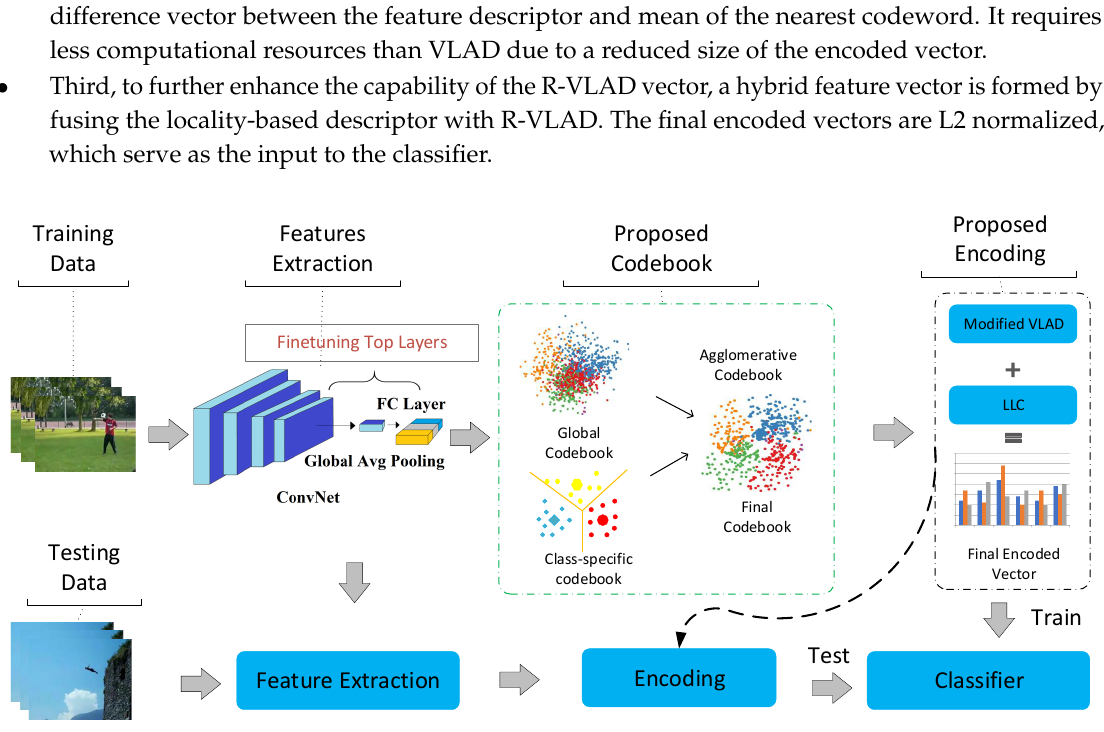
Figure 1. Framework of proposed